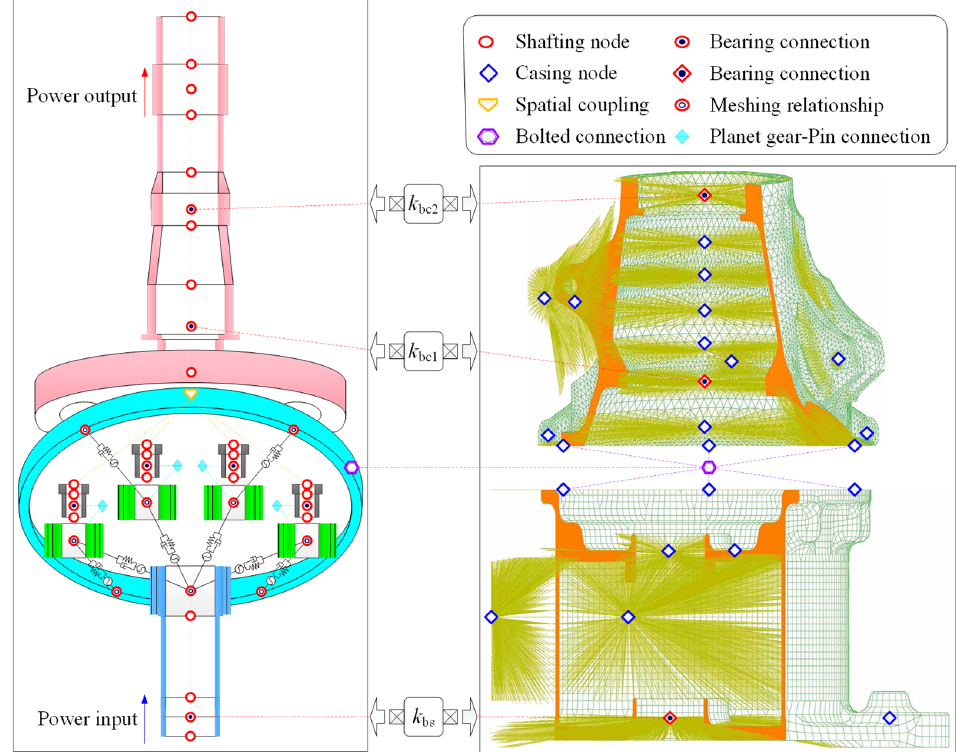
Table 2. Bearing stiffness.